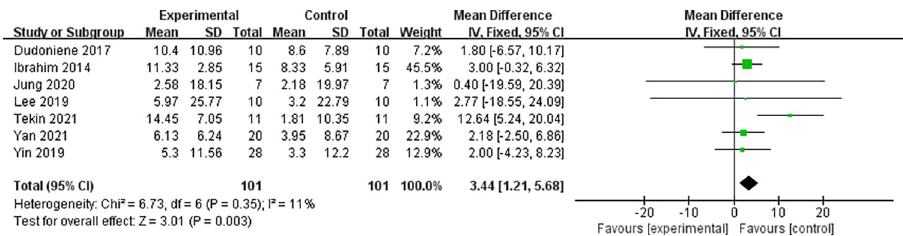
Fig 5. Effect of WBV training on GMFM88-E score in children with cerebral